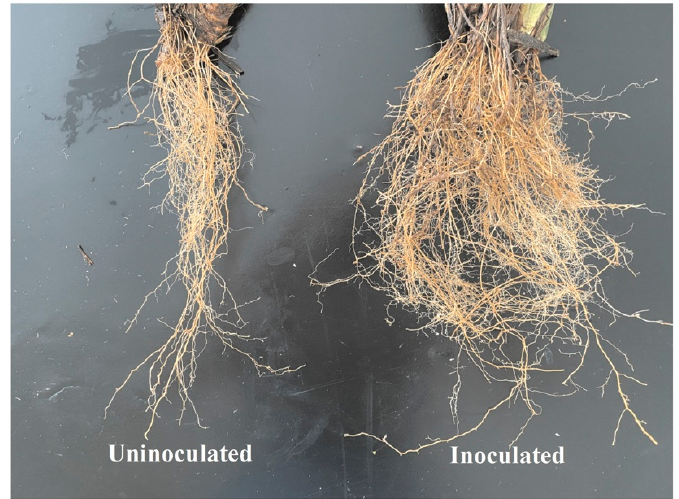
Figure 7. Root development of red rice grown under water restriction and inoculation conditions (50– 55% field capacity). (50–55% field